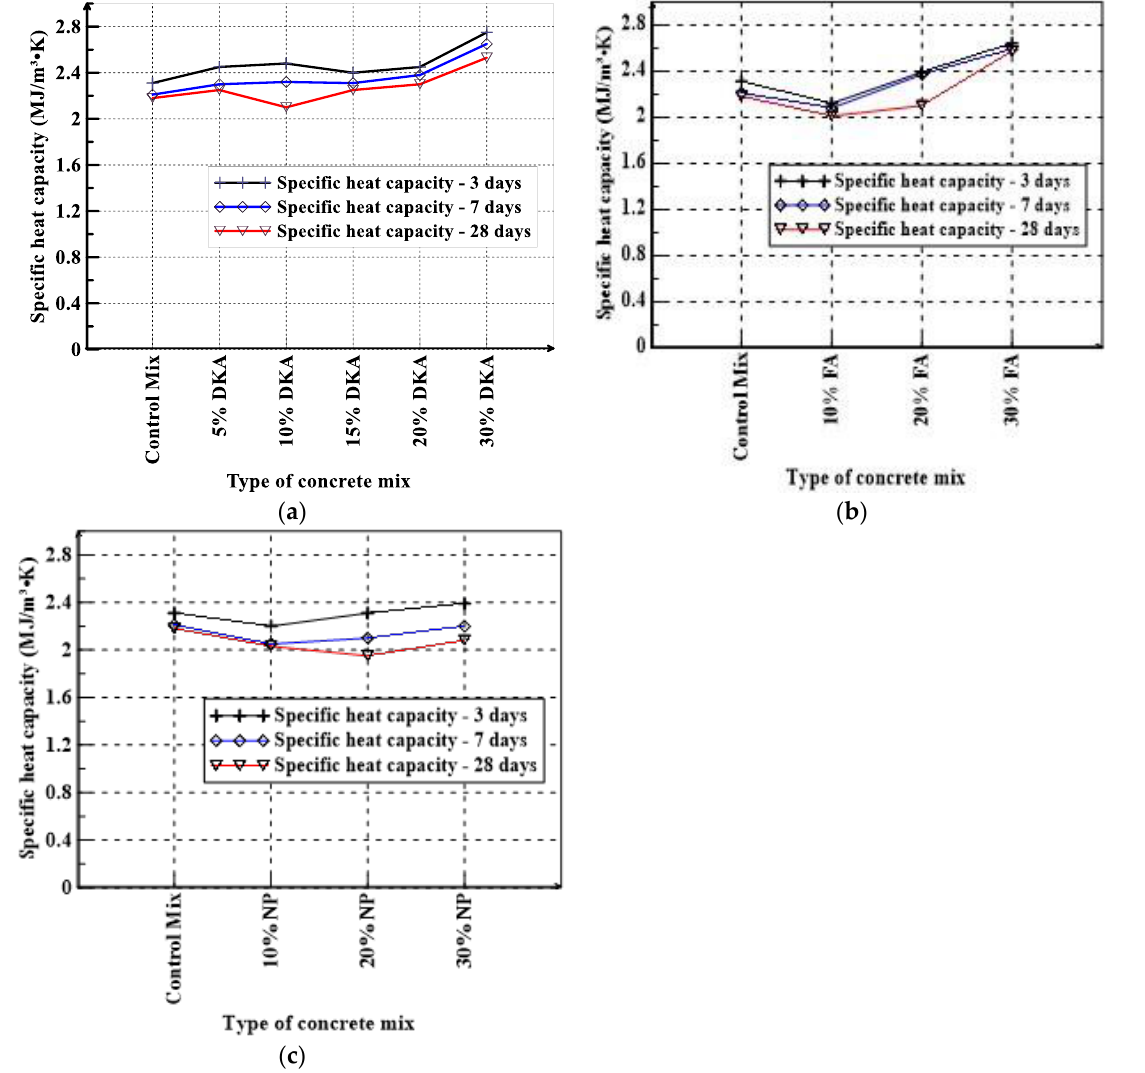
Figure 21. Specific heat of ( a ) DKA, ( b ) FA, and ( c ) NP concrete mixes.